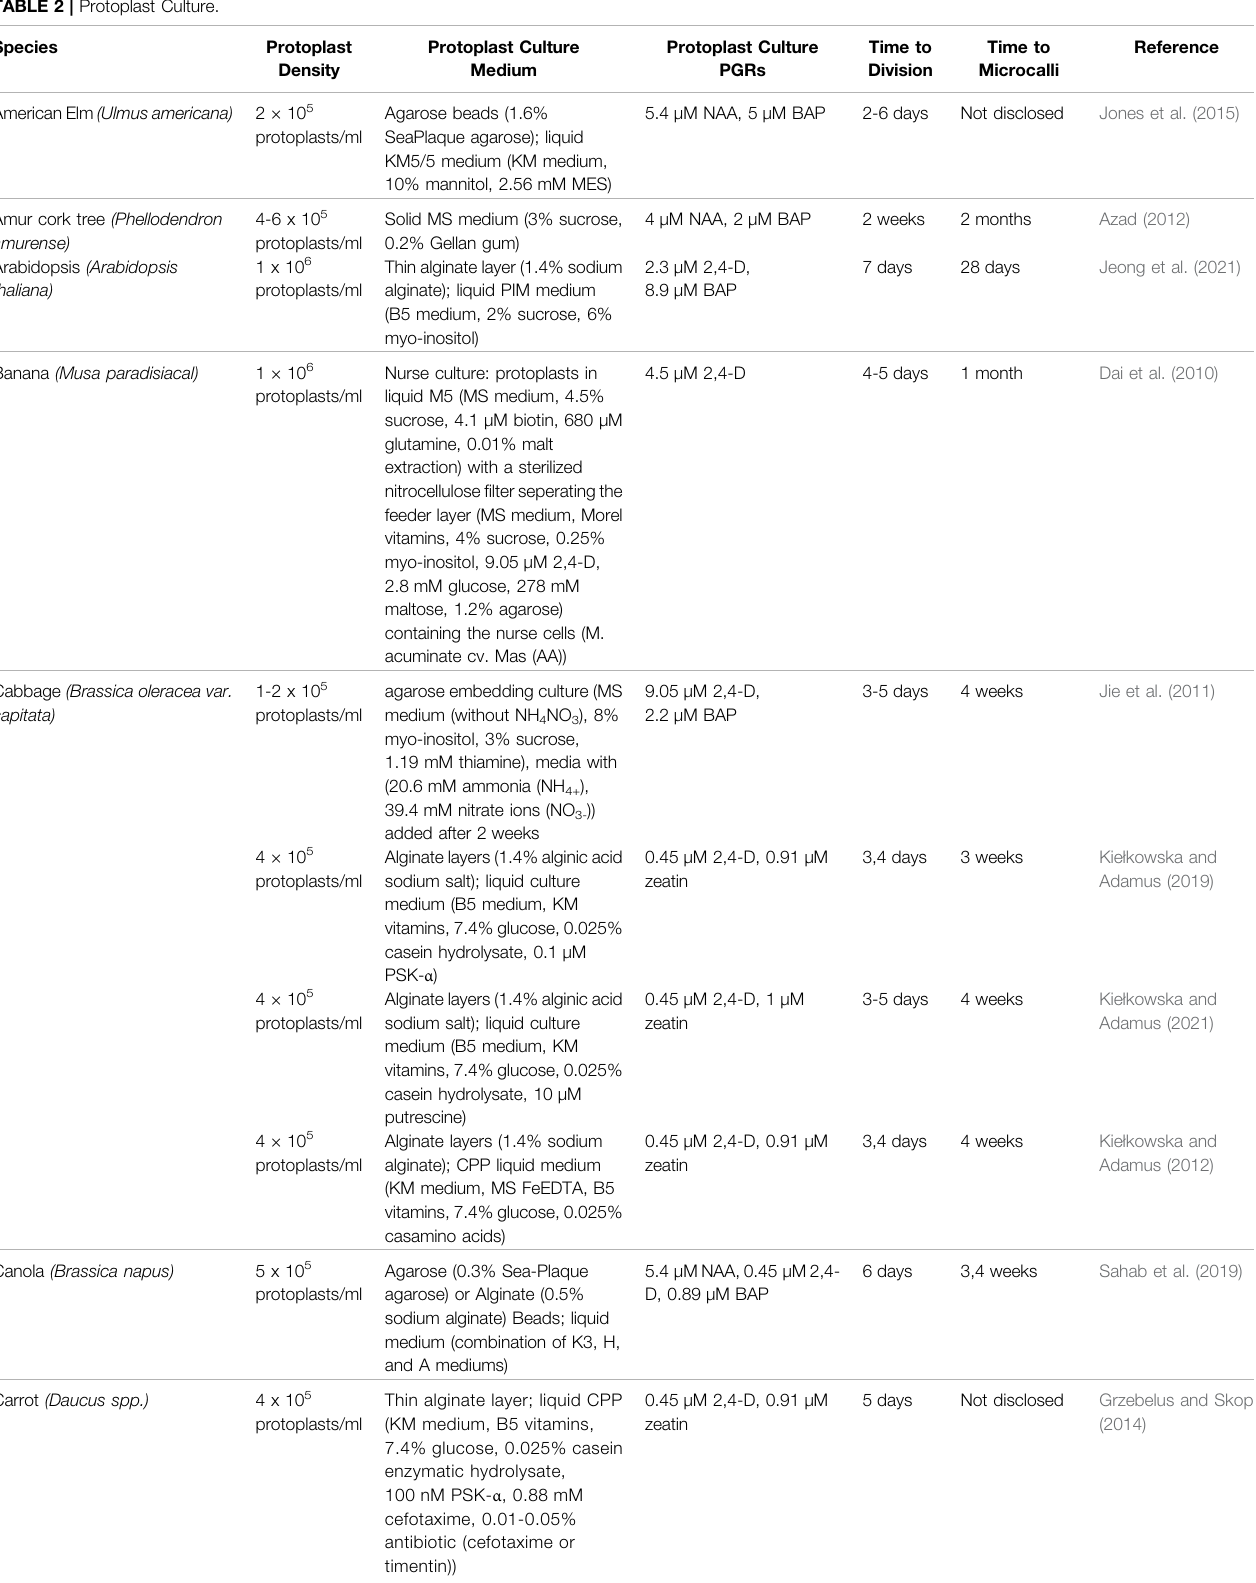
TABLE 2 | Protoplast